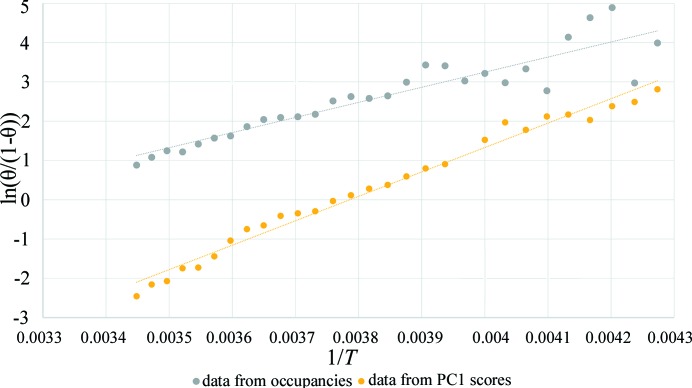
Plot and linear regression of the linearized van ’t Hoff equation. In the grey plot, θ is calculated as occCO2/occCO2max. y = 3842.6x − 12.123, R
2 = 0.8486. In the yellow plot, θ is calculated as PC1/PC1max, using PC1 scores from the analysis of real data. y = 6212.3x − 23.52, R
2 = 0.983.